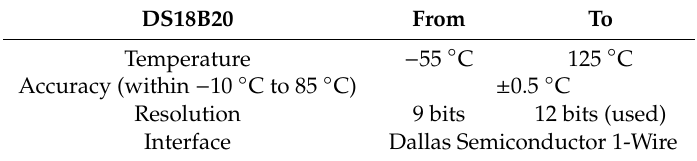
Table 3. Specification of the DS18B20 digital temperature sensor employed for monitoring of the